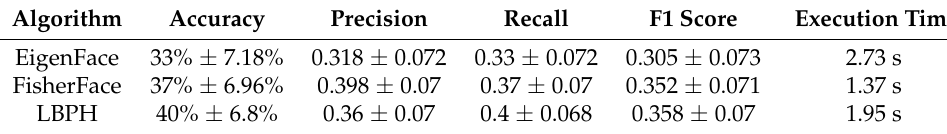
Table 3. Accuracy, precision, recall, F1 score, and execution time on 5_Celebrity dataset.